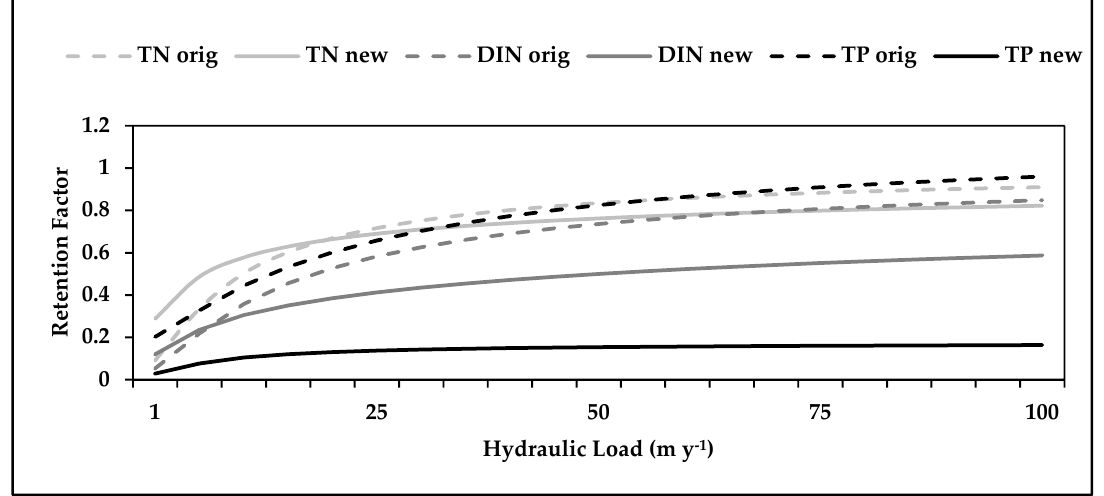
Figure 9. E ff ect of original and adjusted retention parameters on the retention factor as a function of the hydraulic load (specific total runo ff for TP retention was 1 l s − 1 km − 2